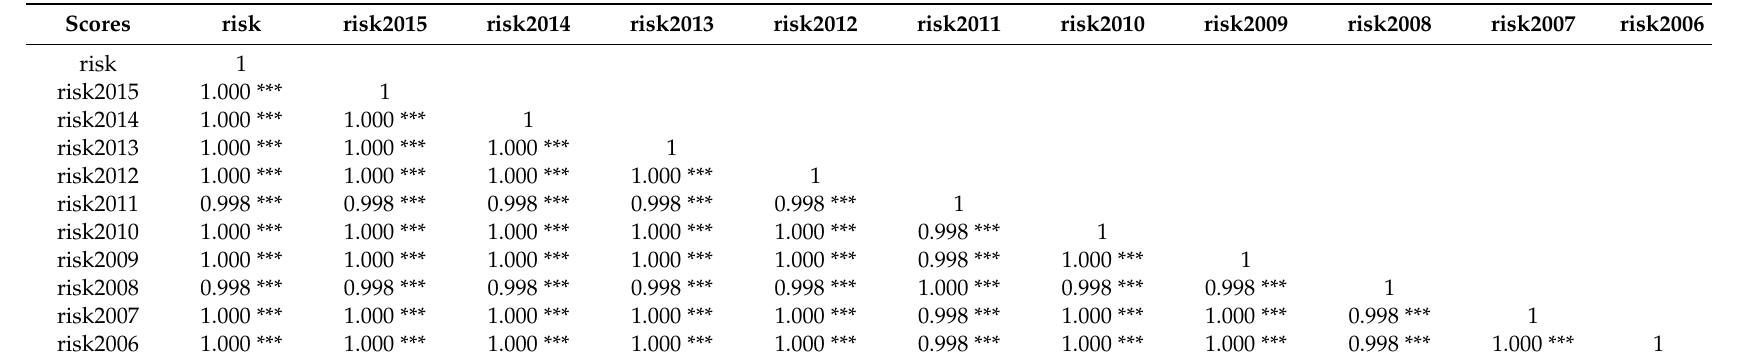
Table 6. Pearson correlation variables among scoring PCA bankruptcy risk variables obtained by